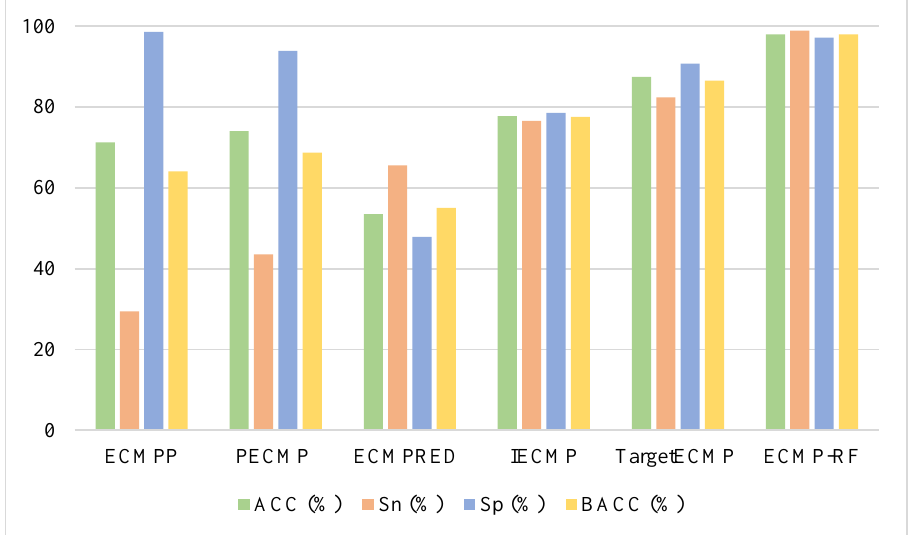
Figure 5. Comparison of ECMP-RF on testing dataset with existing methods.